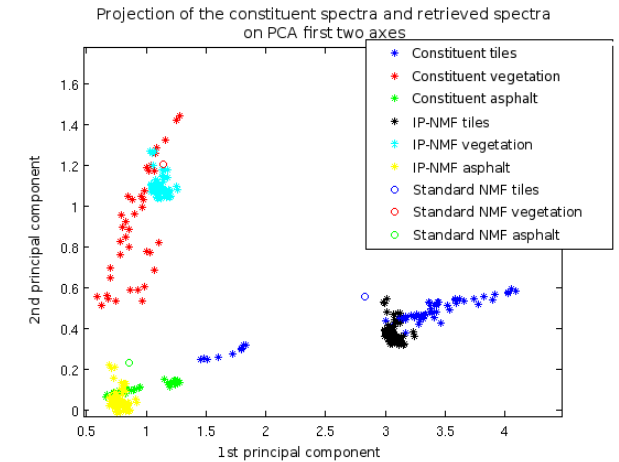
Figure 7. Projection onto the first two PCA axes of constituent spectra (blue, red, green stars), IP-NMF spectra (black, cyan, yellow stars) with µ = 30 and standard NMF spectra (blue, red, green